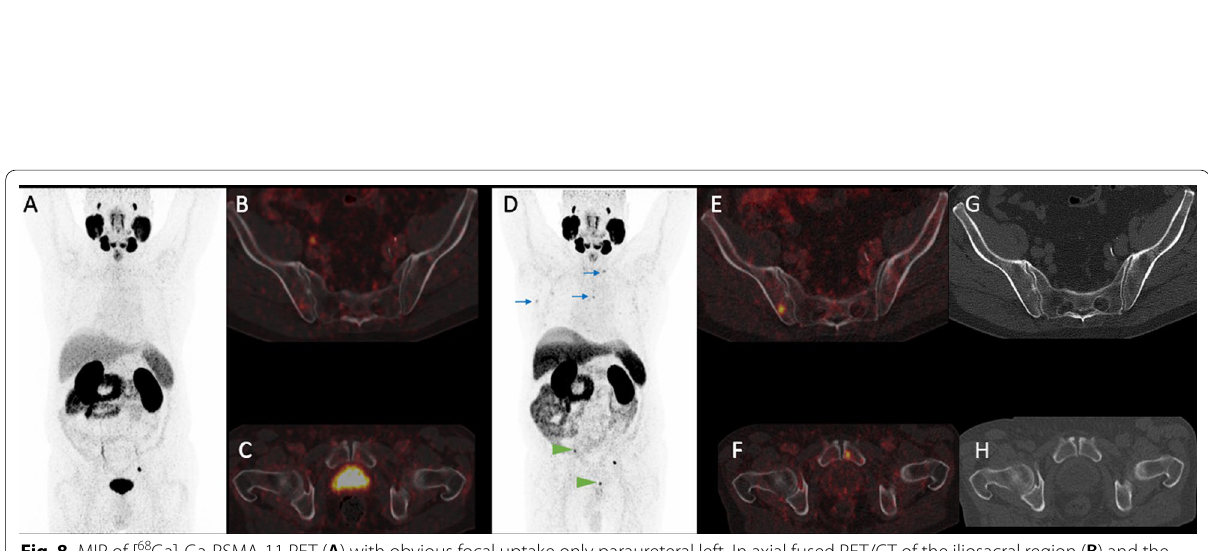
Fig. 8 MIP of [ 68 Ga]-Ga-PSMA-11 PET ( A ) with obvious focal uptake only paraureteral left. In axial fused PET/CT of the iliosacral region ( B ) and the symphysis ( C ), no focal uptake suggestive for malignancy is present. The MIP of [ 18 F]-F-PSMA-1007 ( D ) shows beside the concordant paraureteral uptake on left side intensive focal uptake in the right iliac bone (SUV max : 16.5) and the left pubic bone (SUV max : 14.8 arrow heads). Axial fused PET/CT confirms the intraosseous location of both the iliac ( E ) and the pubic metastasis ( F ). While the right iliac lesion has a slight hypersclerotic correlate in CT-imaging ( G ), there is no morphologic correlate in the left pubic bone detectable in low-dose CT ( H ). Auxiliary findings in [ 18 F]-F-PSMA-1007 ( D ): presumable unspecific uptake in cervical ganglia, mediastinal and axillary lymph nodes (blue arrows) as well as multifocally in the rib